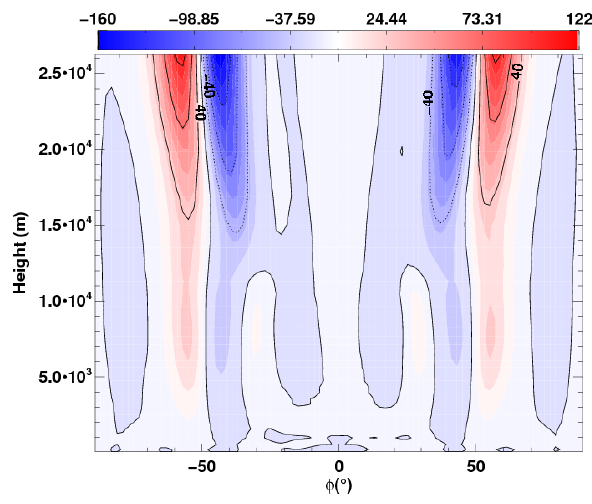
Figure 12. Figure, for the Earth-like test (Menou and Rauscher, 2009), showing the differences EG–ND of the zonally and tempo- Fig. 12. Figure, for the Earth–Like test (Menou and Rauscher, rally averaged EKE (see Table 2 for explanation of model types). 2009), showing the differences EG − ND of the zonally and tem- porally averaged EKE (see Table 2 for explanation of model types).